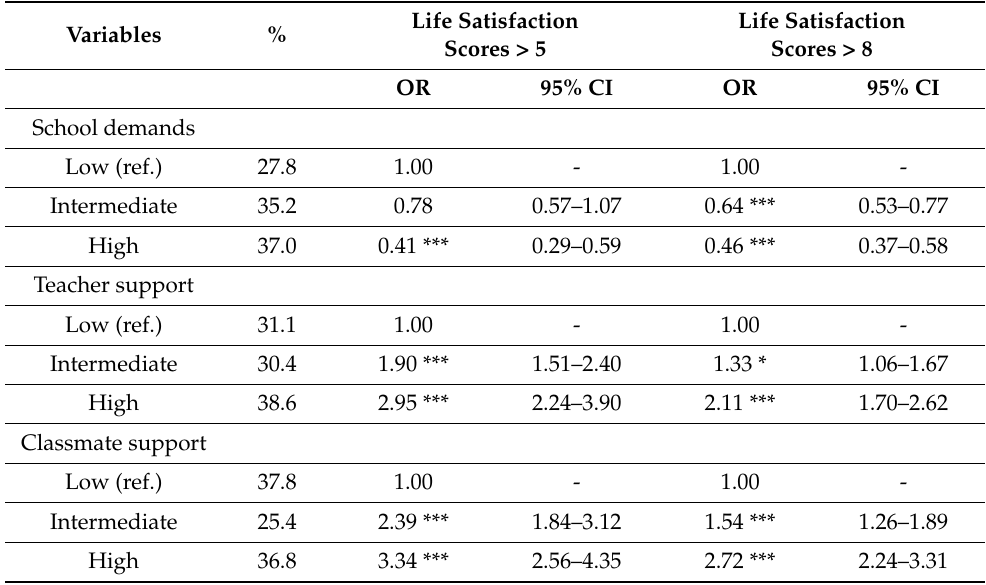
Table A1. Odds ratios and 95% confidence intervals from binary logistic regressions of life satisfaction. Adjusted for gender, grade, parental country of birth, and family affluence. n =